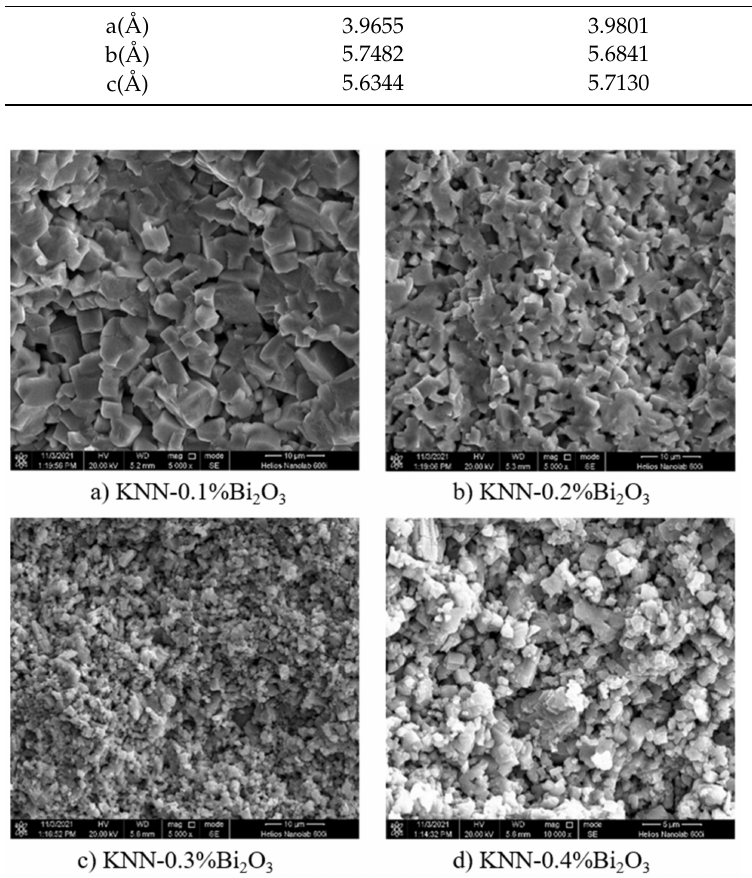
Figure 2. SEM of KNN-xBi 2 O 3 piezoelectric